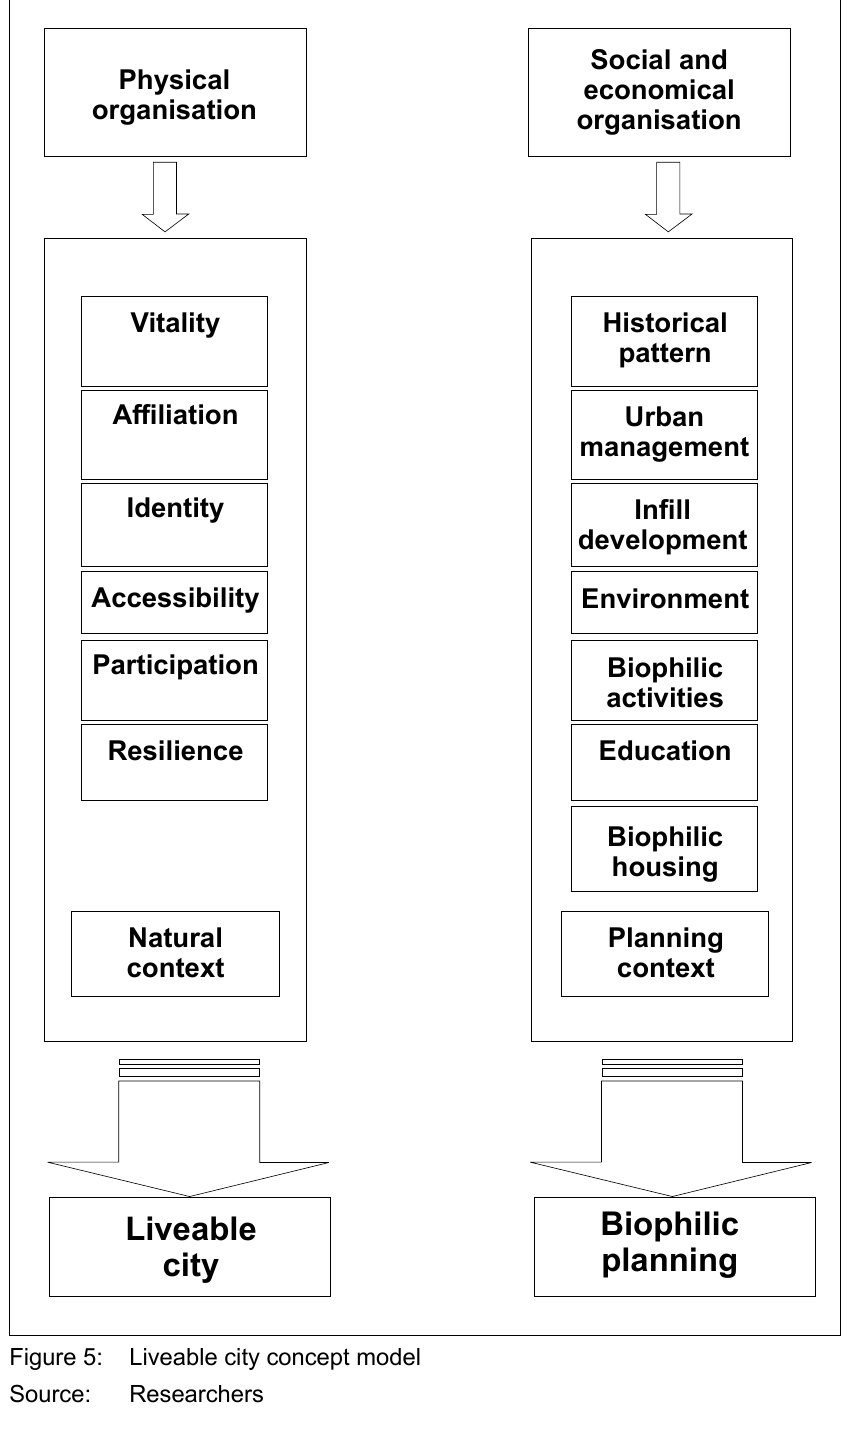
Ranking of biophilic planning variables in